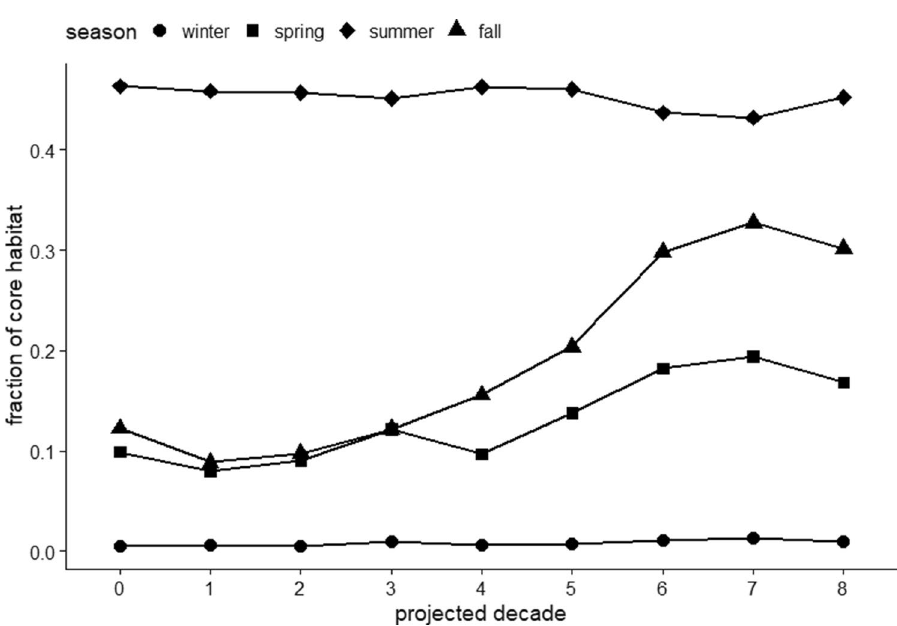
Figure 5. Change in fraction of the NW Atlantic shelf region identified as core habitat for loggerheads across the projected 80 years binned by decade. Spring and fall are projected to have the largest change. Decade ‘0’ refers to the observed